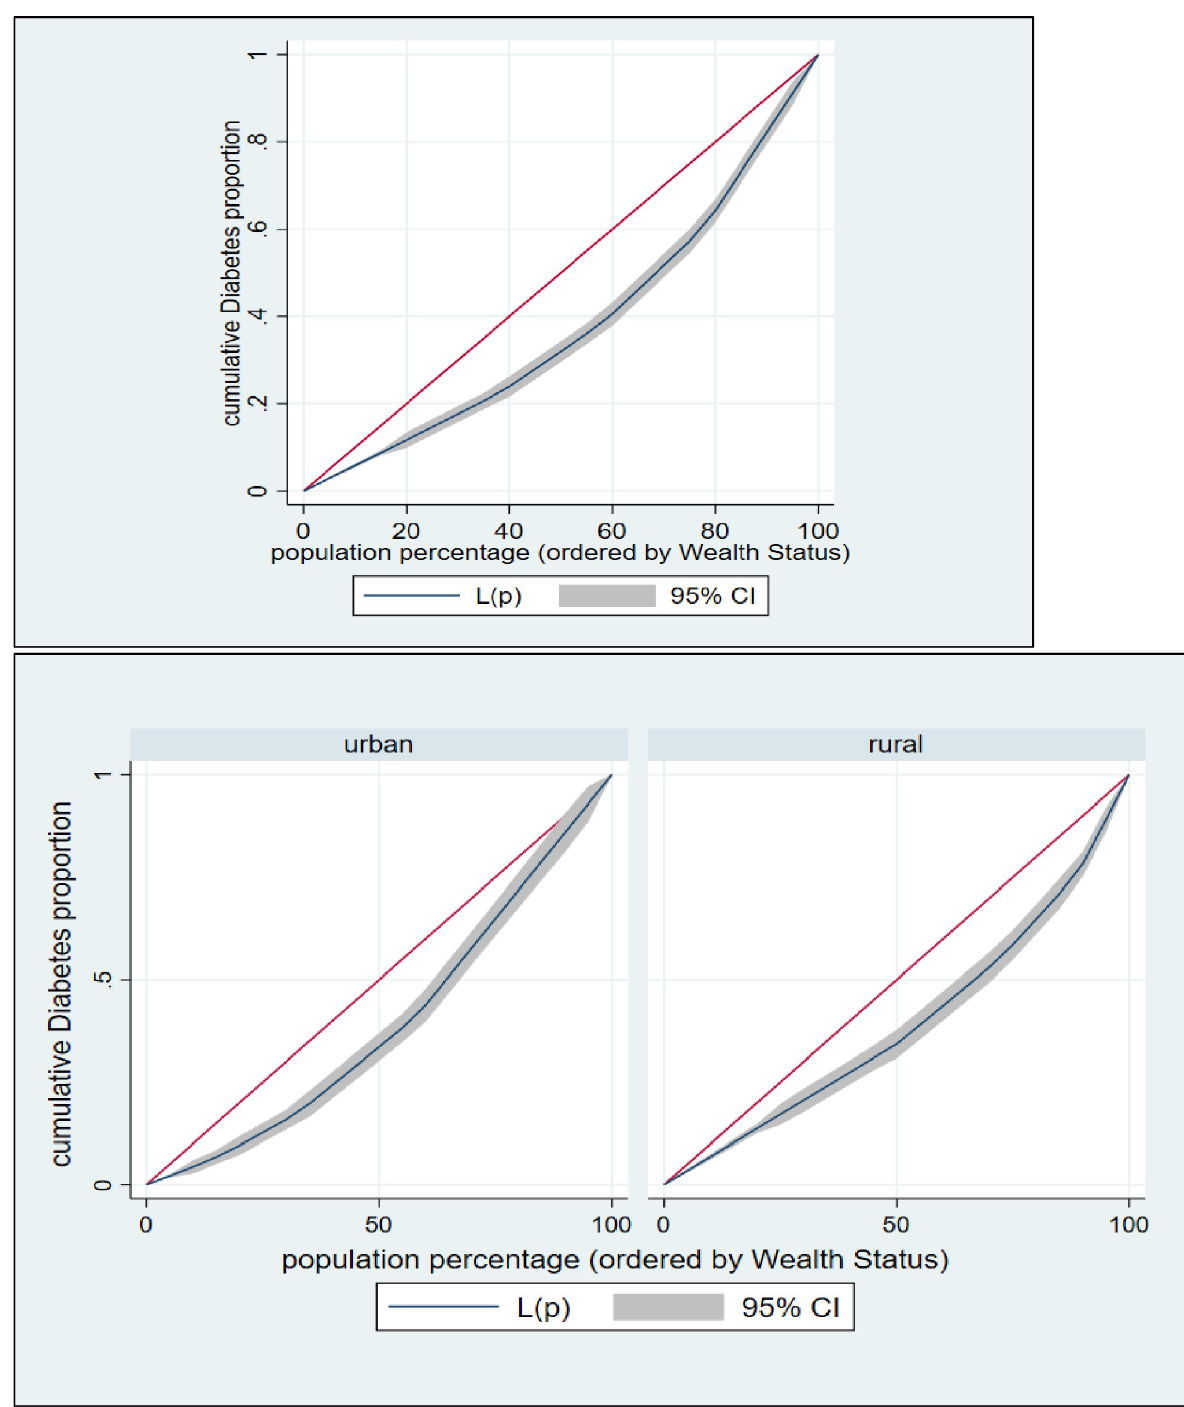
Fig 3. Concentration curve for diabetes over wealth status.